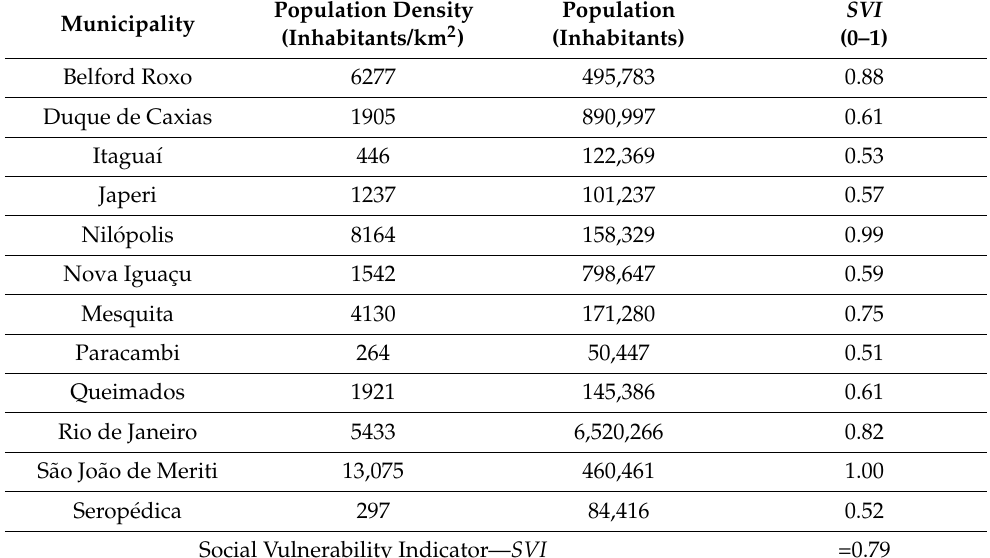
Table 16. Social vulnerability indicator ( SVI )